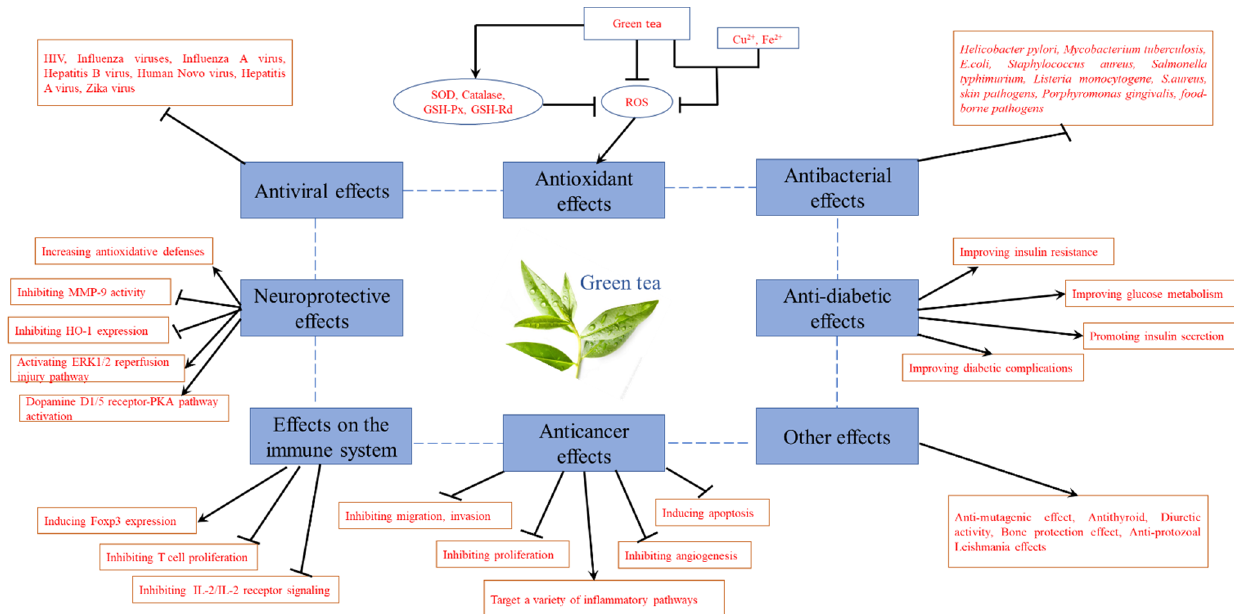
Figure 9. Pharmacological effects of green tea. Table 1. Pharmacological effects of green tea.